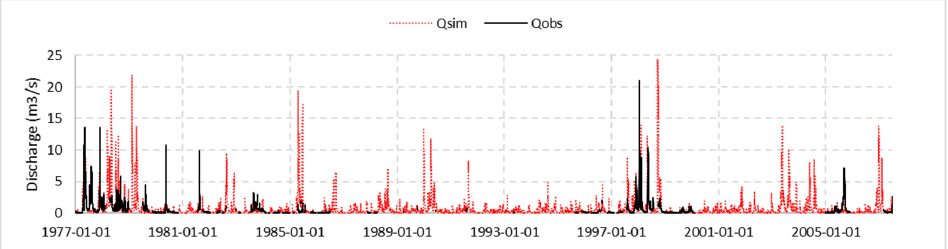
Figure 2. Observed and simulated daily runoff for station (2FCO5) from 1977 to 2007 using AWBM.